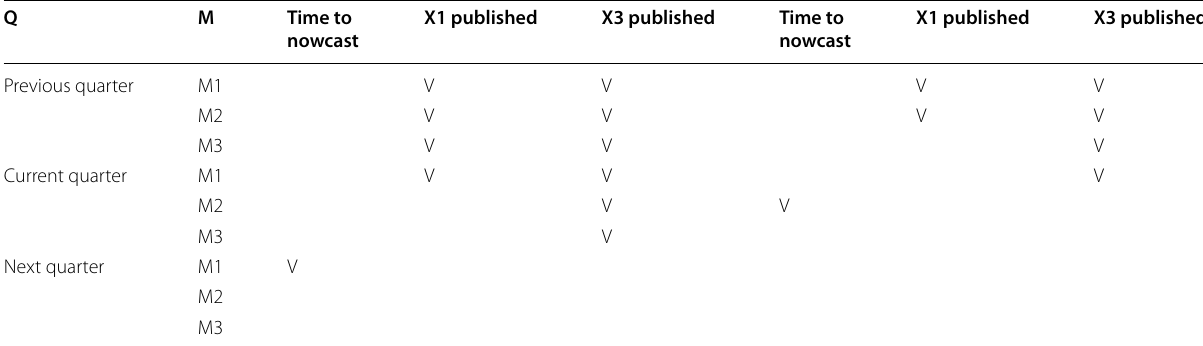
Table 3 Publication of retail trade volume index and economic sentiment indicator across time Q